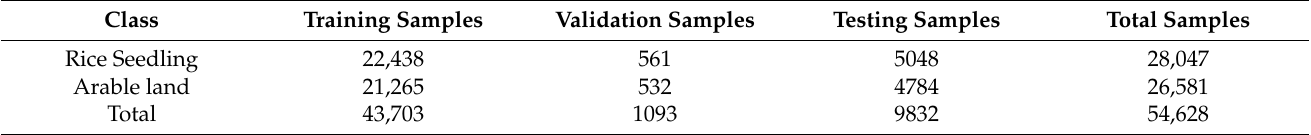
Table 5. The number of images used for training, validation, and testing in the rice seedling da- taset.